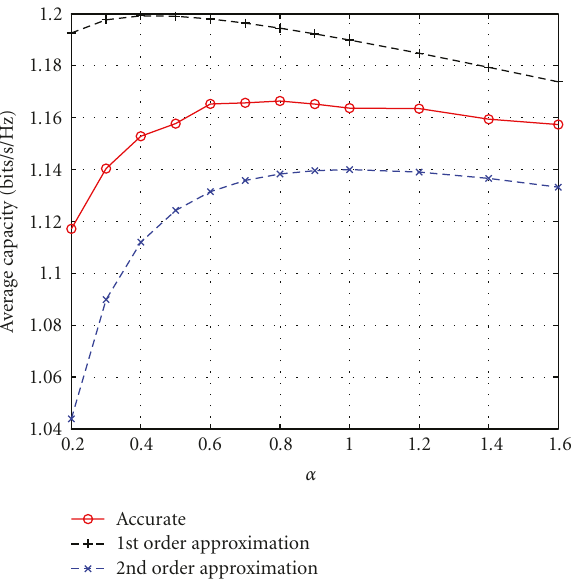
Figure 7: Performance versus various α in the high β region. Figure 8: Performance versus various α in the low β region.